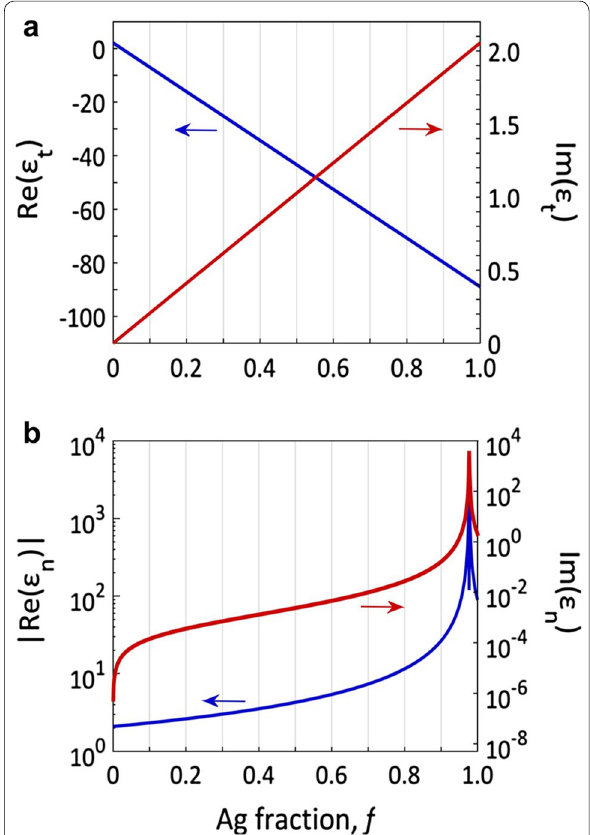
Fig. 2 Dielectric tensors of Ag/SiO 2 -based hyperbolic metamaterial system calculated at 1.3 µm wavelength by applying an effective medium approximation. a Tangential component ε t : real part (blue; left axis) and imaginary part (red; right axis). b Normal component ε n : real part (blue; left axis) and imaginary part (red; right